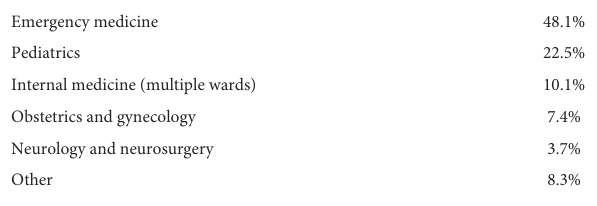
TABLE 1 Sample percentages per